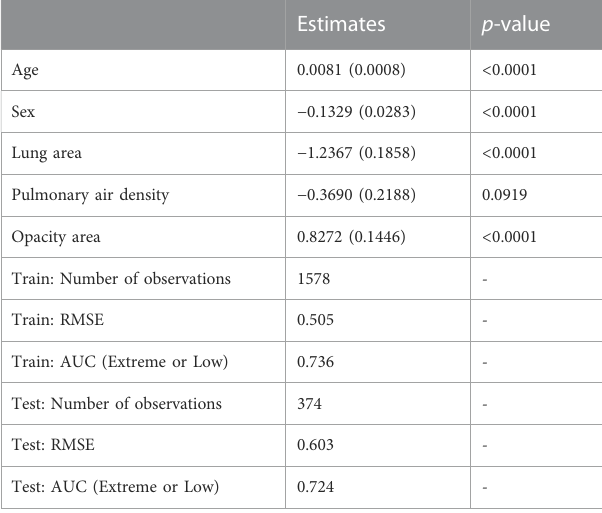
TABLE 3 Relationship of the model variables with oximetry. In a total of 1578radiographs, theassociationofthesevariableswasanalyzedbymeansof multiple linear regression with the fi gures obtained in pulse oximetry. Estimated parameters of the models. Standard errors in brackets. AUC = area under the curve, where the target is “ Extreme ” or “ Low ”